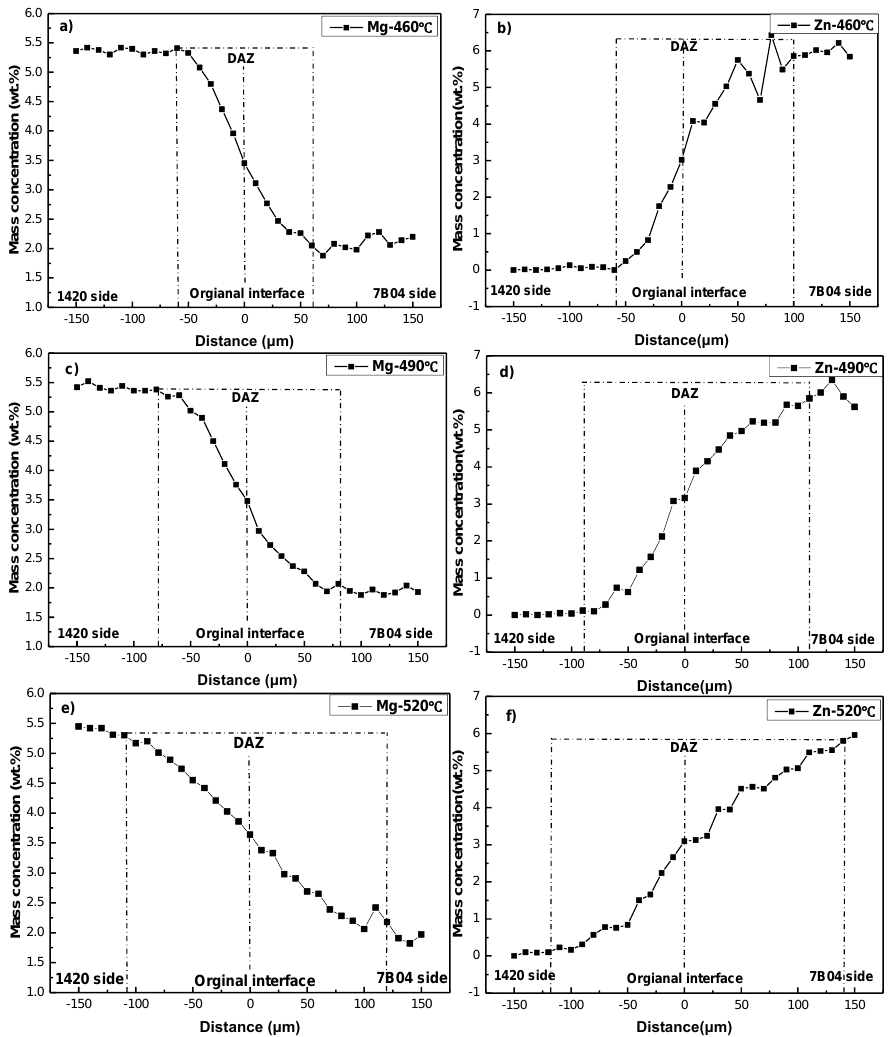
Figure 11. The distribution of main alloying elements (Mg and Zn) across the interface after bonded under different temperatures: ( a , b ), 460 °C; ( c , d ), 490 °C; ( e , f ), 520 °C.